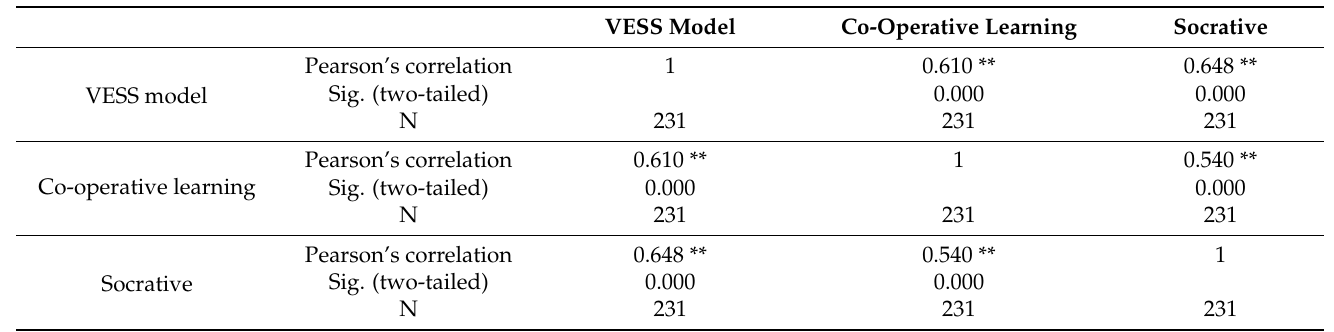
Table 5. Results of the bivariate correlations of the dimensions of the questionnaire on the perceptions of university students on the VESS Model.